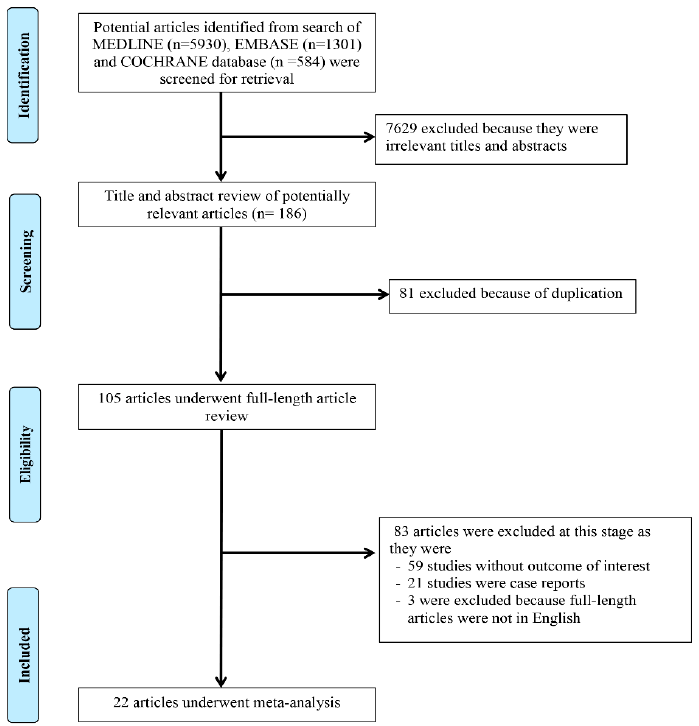
Figure 1. Outline of our search methodology.